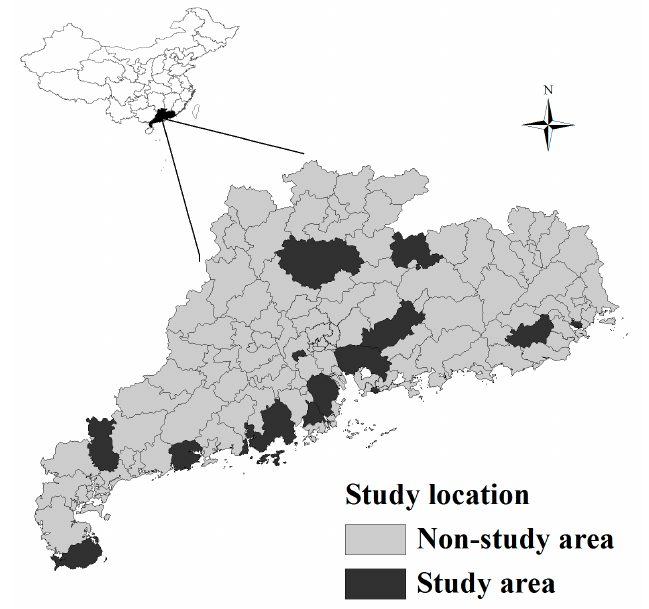
Figure 1. Geographical location of the study area in